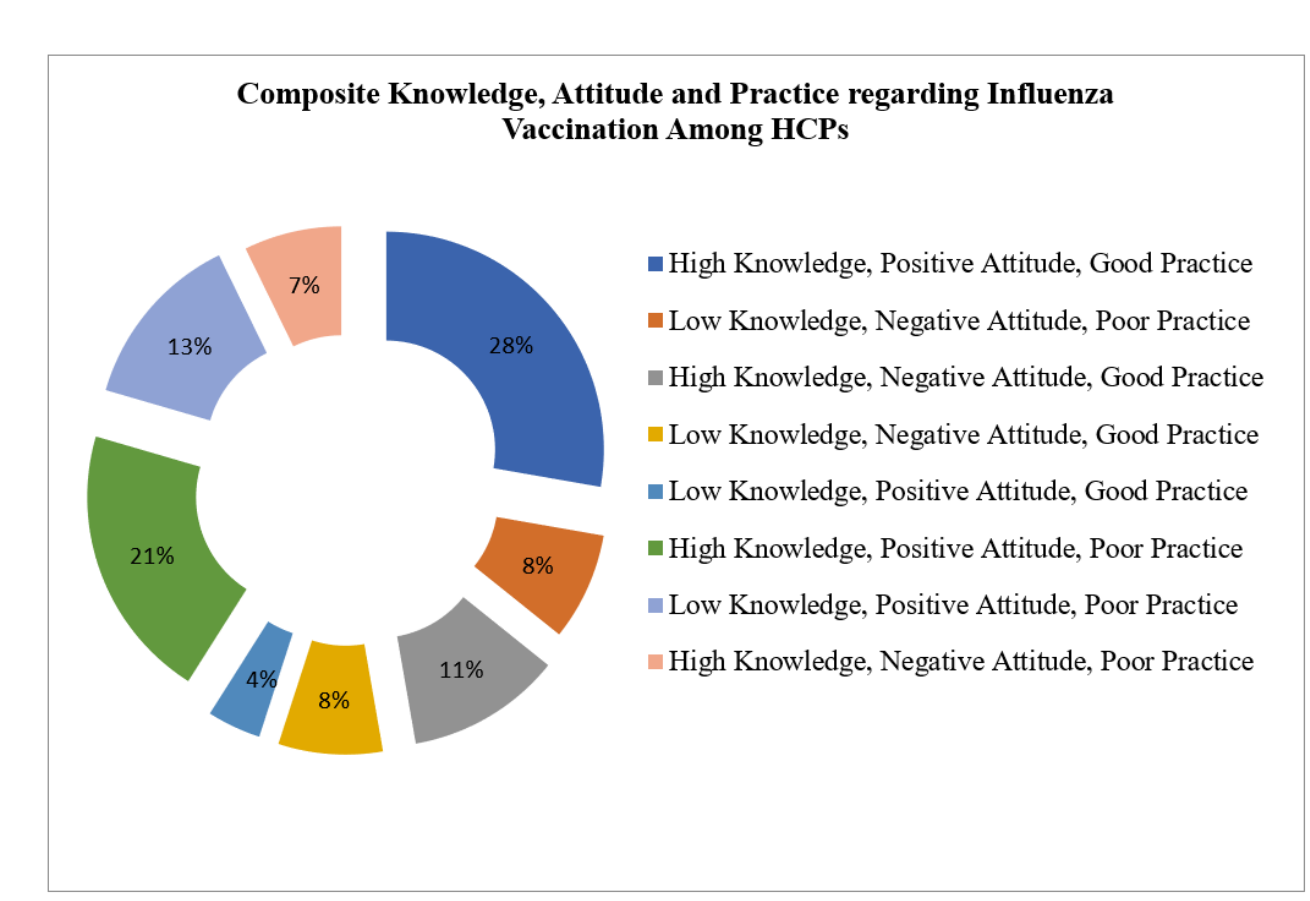
Figure 2. Composite total KAP score.